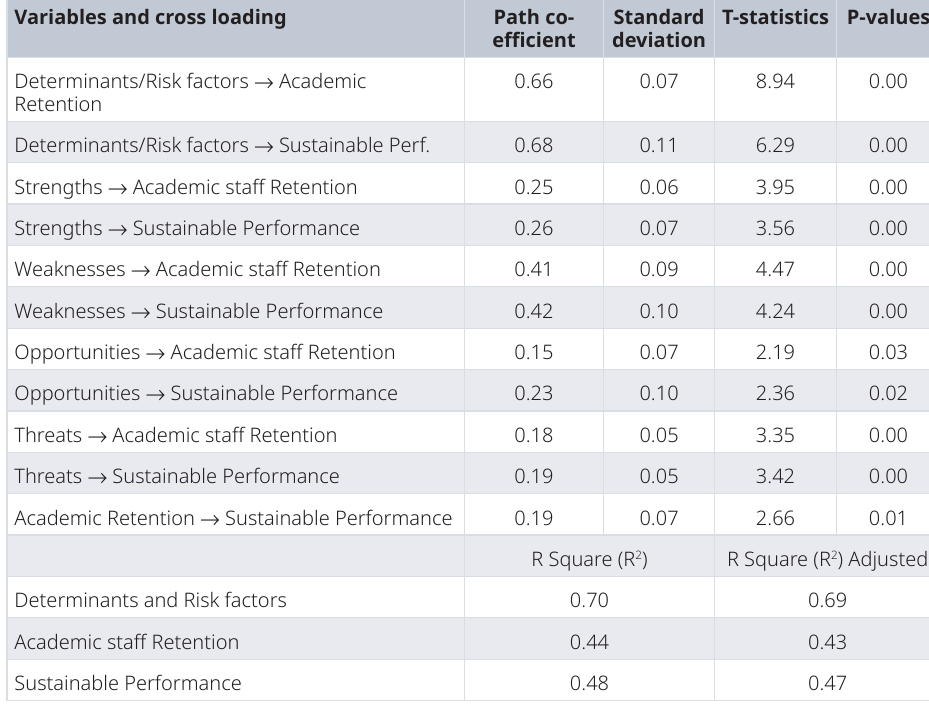
Table 5. Path coefficients for idea exploration and task performance.